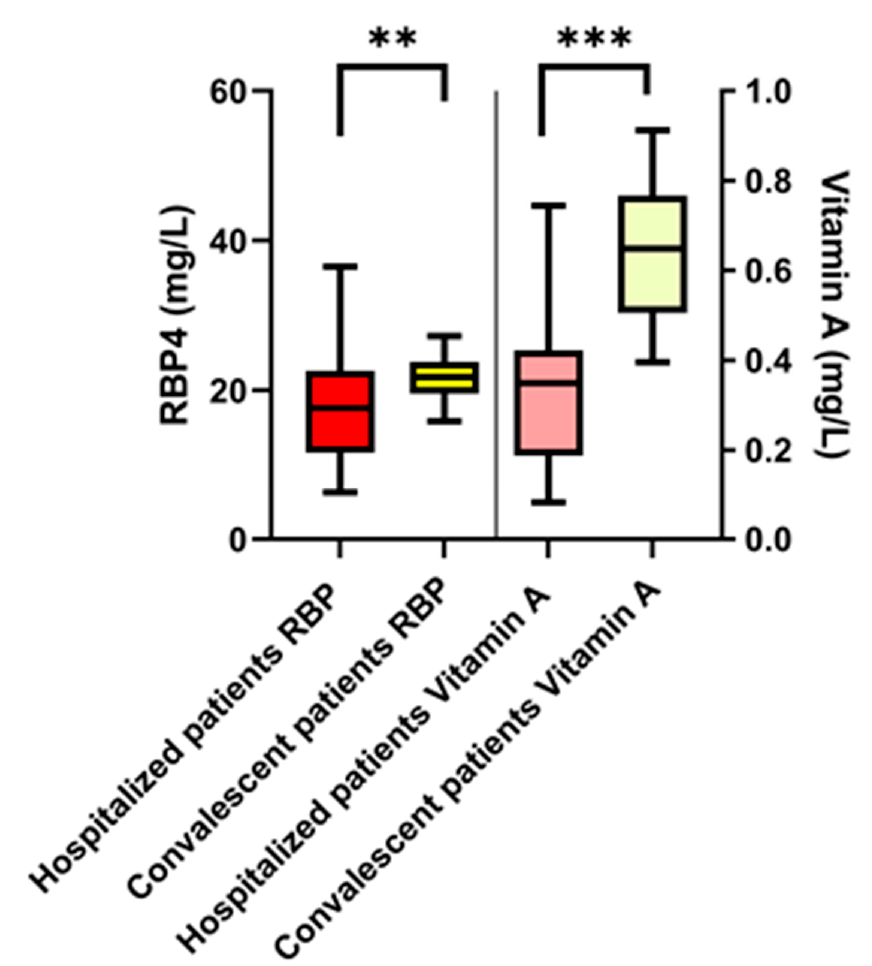
Figure 1. RBP4 and vitamin A plasma levels in acutely ill patients compared to convalescent pa- tients. The Mann–Whitney U (Wilcoxon) test showed a significant difference for both RBP4 and vitamin A. RBP, retinol-binding protein 4; ** p < 0.01, *** p < 0.001.